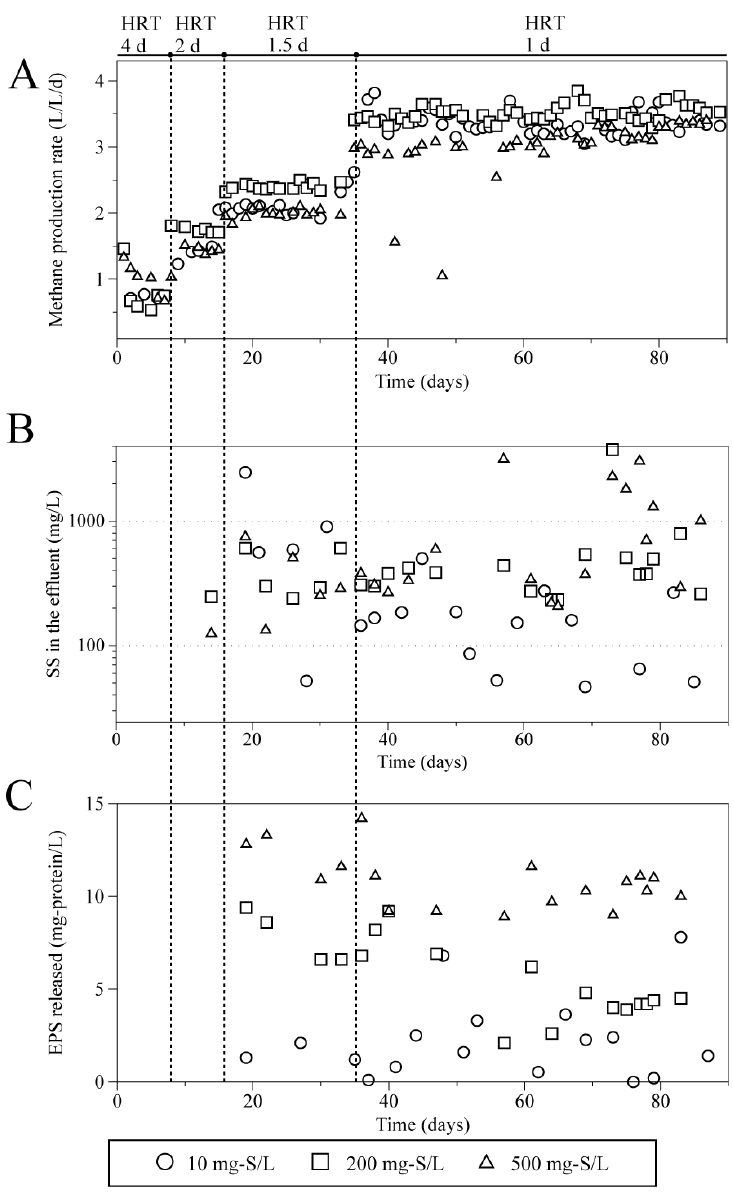
Figure 6. Performance evolutions during the continuous operation of up-flow anaerobic sludge blanket (UASB) reactors at different concentrations of sulfide in the influent wastewater: methane production rate from a unit volume of reactor ( A ), suspended solids (SS) concentration in the effluent ( B ), and EPS protein in the effluent ( C